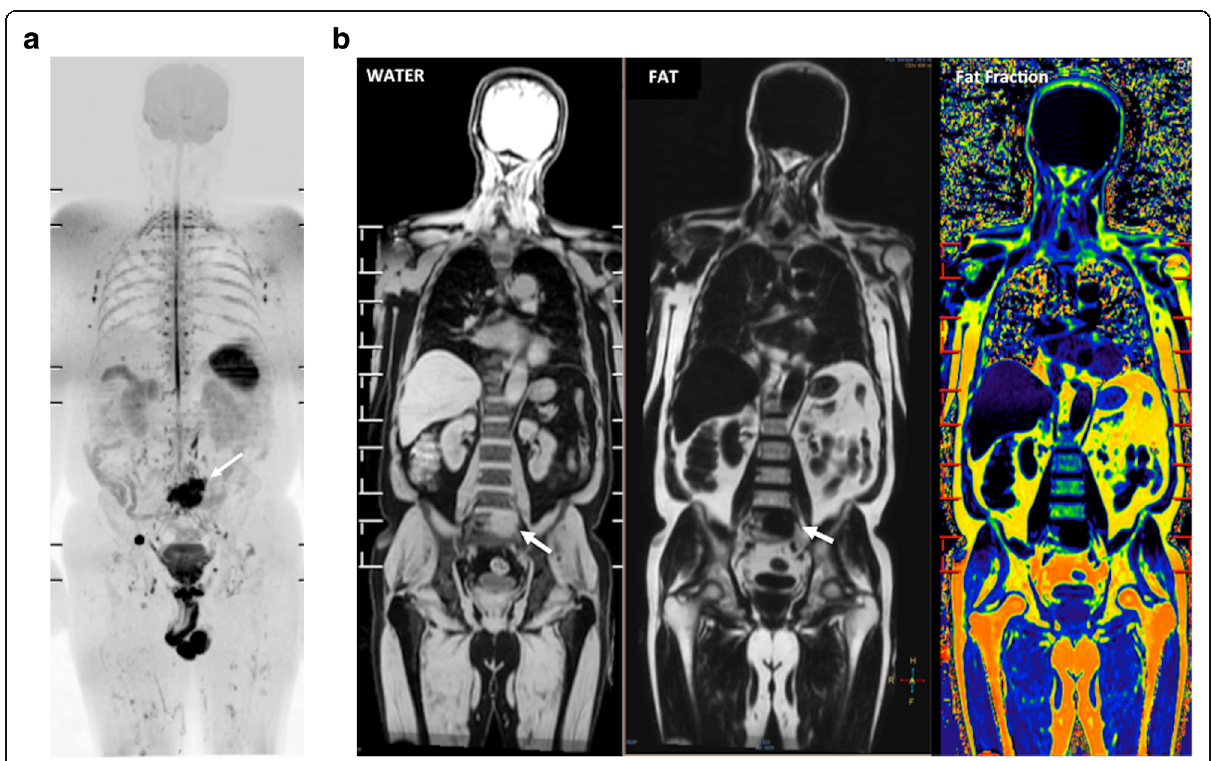
Fig. 5 A 68-year-old man with lung adenocarcinoma. a The whole-body diffusion weighted MR image ( b = 900 s/mm 2 ) depicted a metastatic deposit in the sacrum (white arrow). b Coronal reformatted T1W images obtained using the Dixon technique water only (WATER) (left), fat only (FAT) (middle), and fat-fraction in colored scale (right) evidenced not fat content and increased water in the metastatic lesion (white